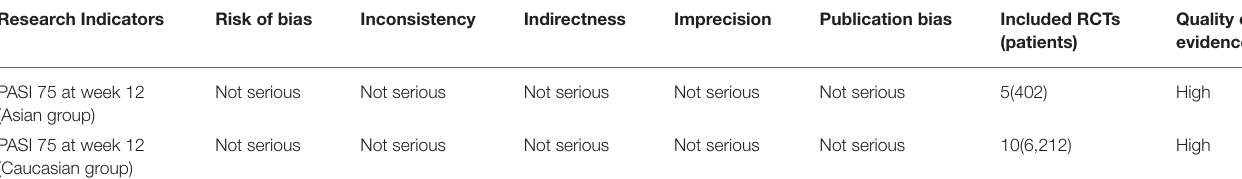
TABLE 1 | Quality of evidence in included systematic reviews with the Grading of Recommendation, Assessment, Development, and Evaluation (GRADE). Research